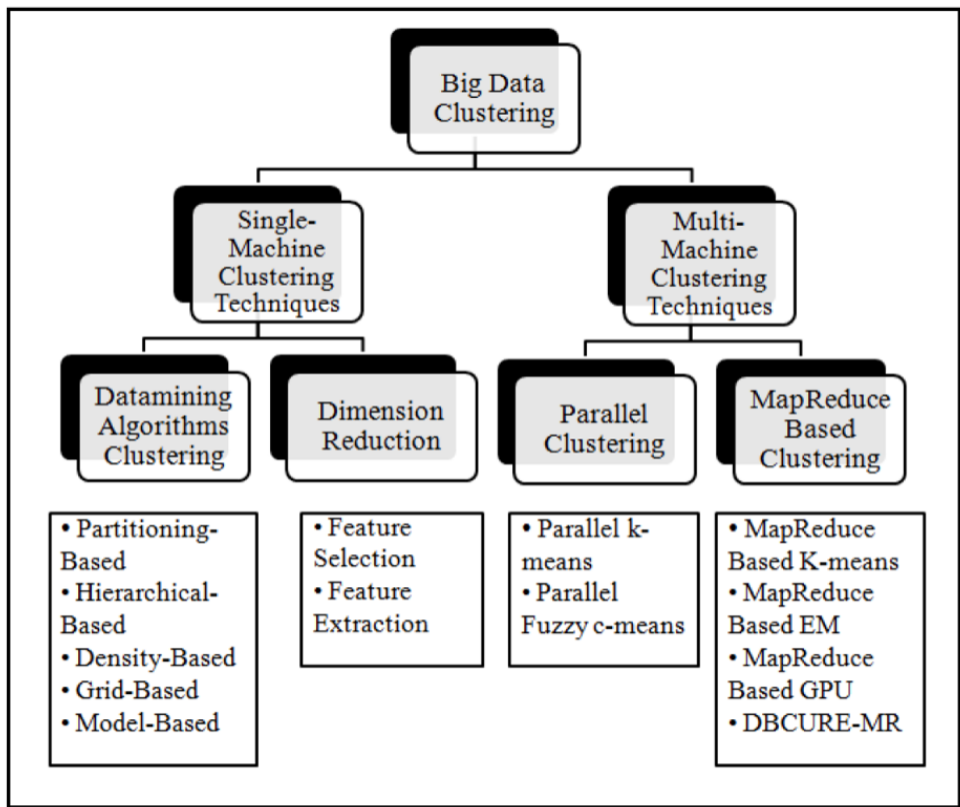
Figure 1. Big data clustering